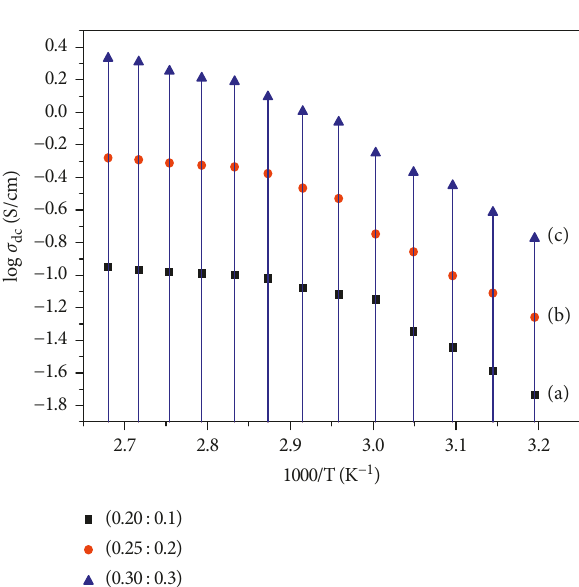
Figure 6: α versus h υ plots of polymer electrolyte films for different PVP/PVA : GO wt.% ratios of (0.20 : 0.1), (0.25 : 0.2), and (0.30 : 0.3).